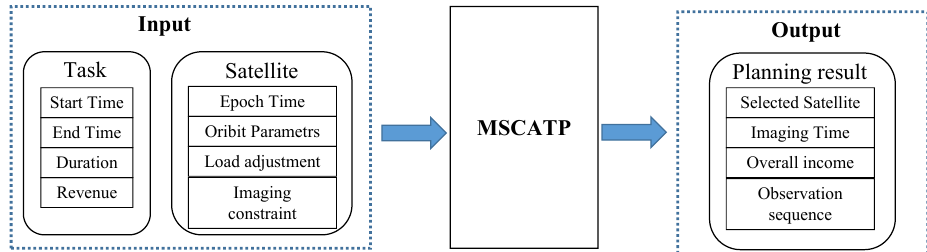
Figure 1. The input and output of MSCATP.